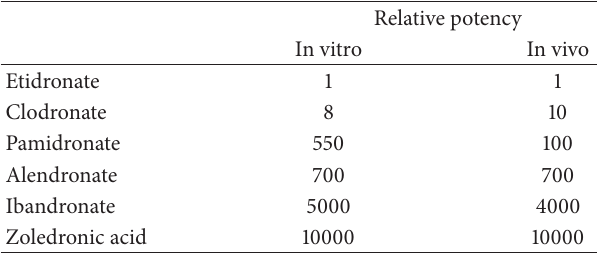
Table 1: Relative potency of different